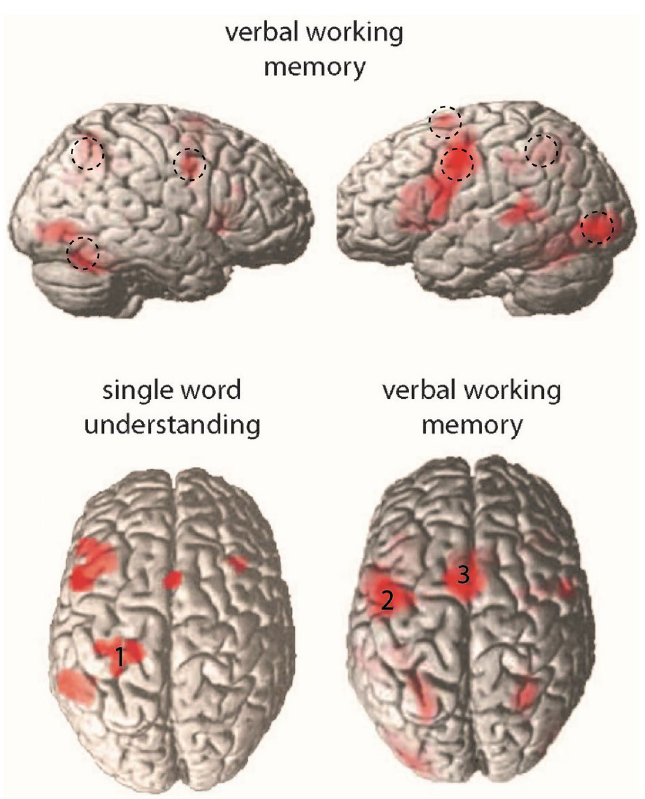
Figure 2. Top panels: Hemodynamic correlates of verbal memory load in the delayed nonmatching-to-sample task. Trials with high memory load are compared against a baseline of low memory load, while keeping constant both task and amount of stimulation. Both encoding and memory maintenance intervals are collapsed into this analysis. All clusters are significant at an FDR-corrected threshold p < 0.05. Bottom panels: Dorsal views of BOLD activation from a previous study 70 during passive reading of action words (against a baseline of looking at matched meaningless symbol strings; bottom left) and of the memory load contrast (as in top panels). Note the central position of the activation focus labelled ‘1’ in sensorimotor cortex in the former and the more anterior foci labeled ‘2’ and ‘3’ in lateral and dorsomedial frontal cortex in the latter. Note also that the anterior left inferior prefrontal activation focus in the former (bottom left) is largely due to the face related words included in the study 70 , which were not used in the present